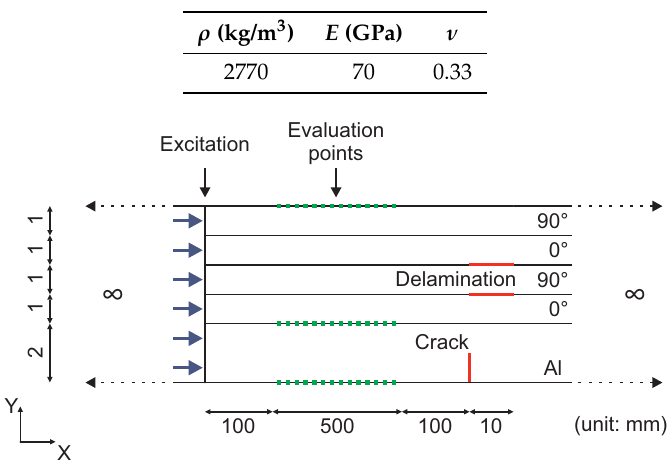
Table 2. Material properties of aluminium used.